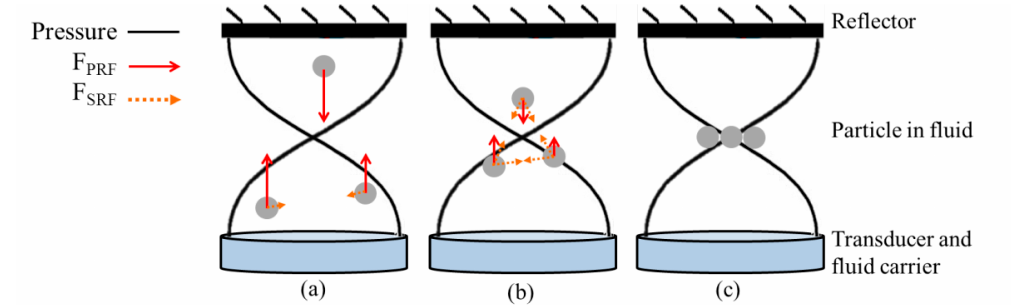
Figure 1. Schematic diagrams of F three stiff and heavy spheres in a fluid subject to an ideal 1-D US field, ( a ) particles moved towards pressure nodal plane by large F the movement; and ( c ) an agglomerate is formed and trapped in a pressure nodal plane. The lengths of the arrows are adjusted for clarity and omitted in the